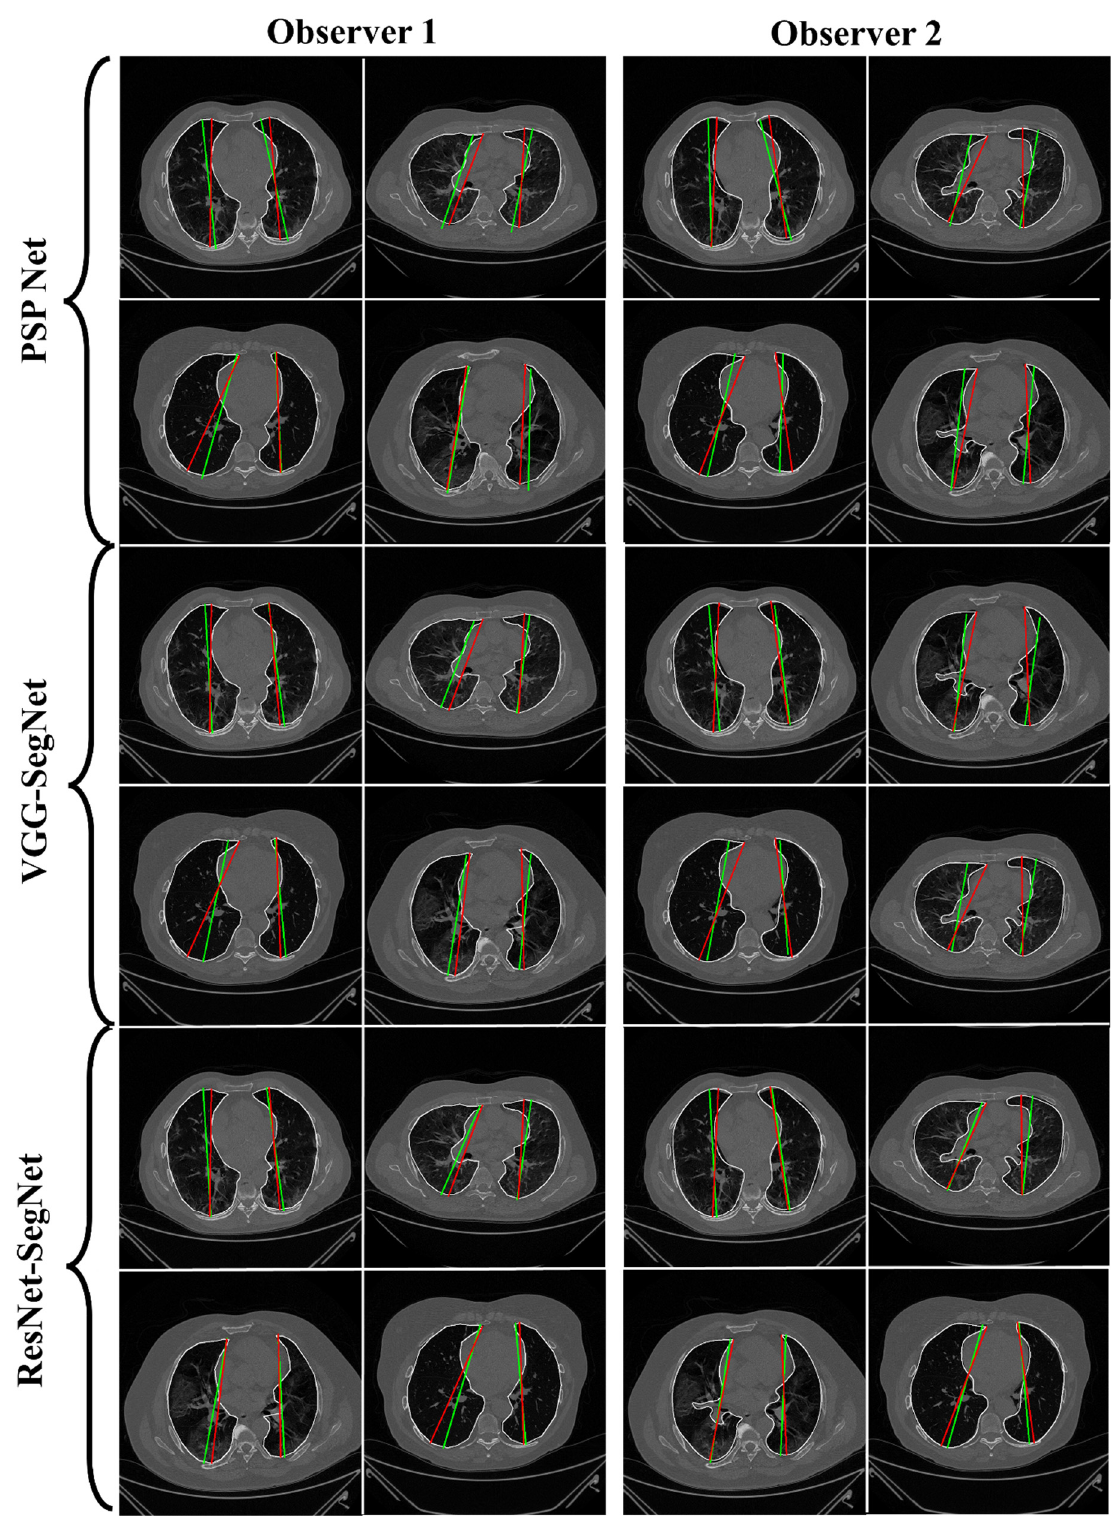
Figure 11. AI-model long axis (green) vs. GT long axis (red) for Observer 1 and Observer 2.